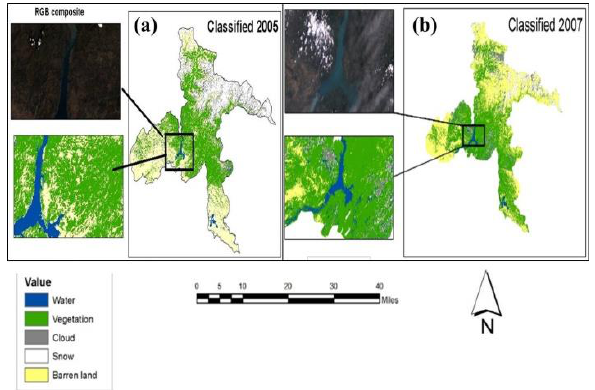
Figure 3: (a) Land Cover Classification Map of 2005 and (b) Land Cover Classification Map of